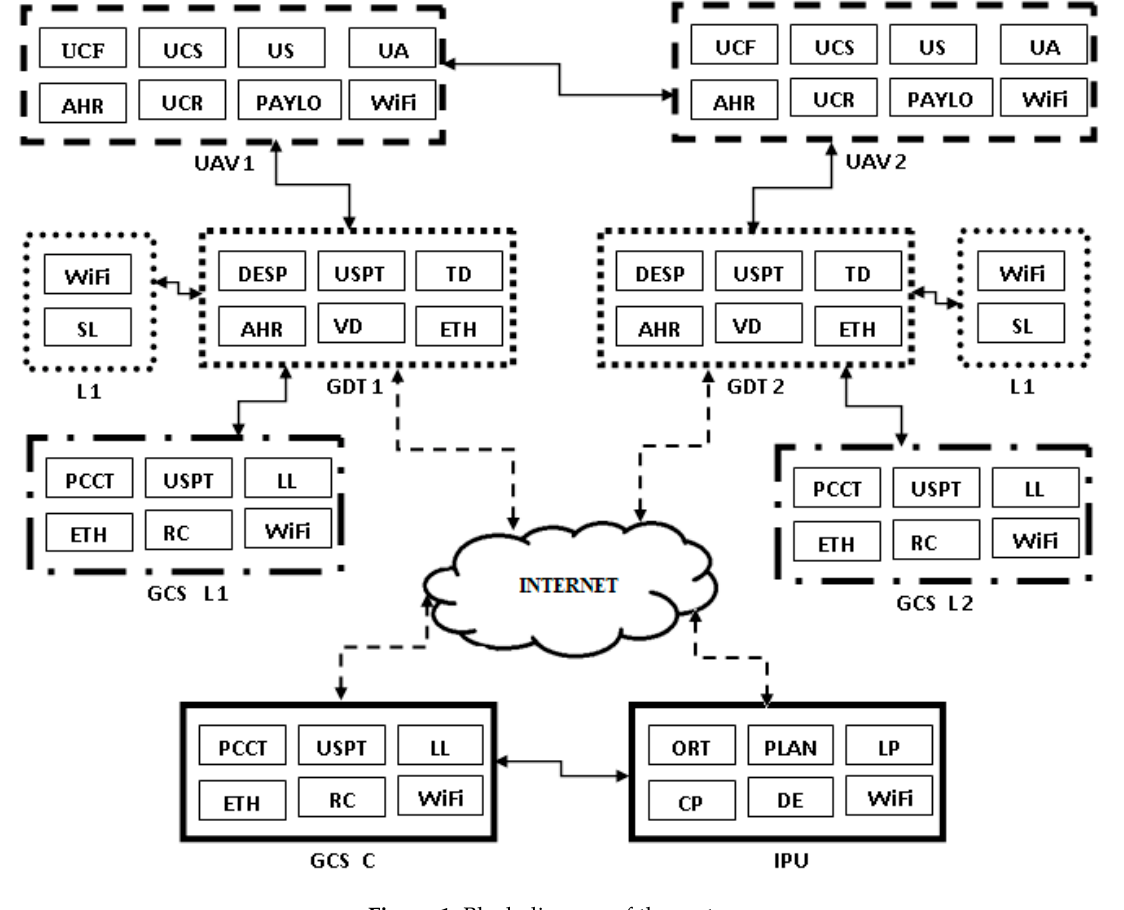
Figure 1. Block diagram of the system. Table 1. MUROS UAV—Abbreviations and functionality.